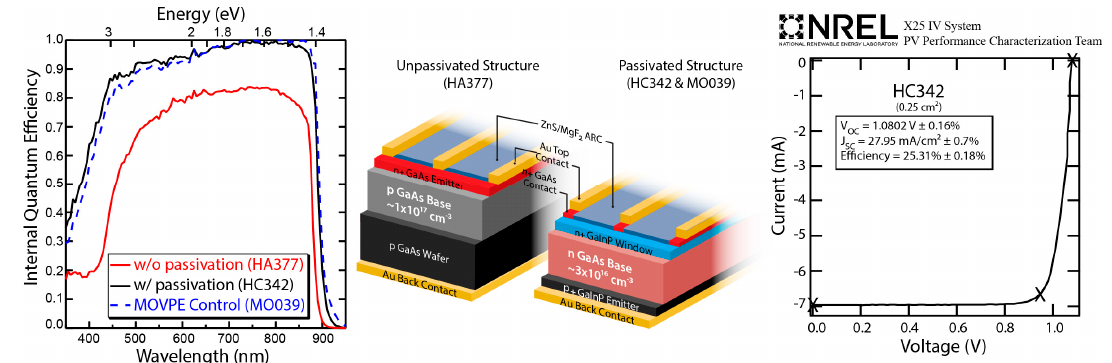
Figure 5. ( Left ) Internal quantum efficiency measurements of an unpassivated ( red ), and a fully passivated ( black ) single-junction GaAs solar cell, grown by D-HVPE at ~60 µ m/h. The dashed blue curve represents data from an MOVPE-grown device with nominally the same structure ( shown in the middle ), but grown at ~6 µ m/h. ( Right ) NREL-certified current-voltage data for the D-HVPE-grown GaAs solar cell with 25.3% conversion efficiency. It shows the current-voltage characteristics of a D-HVPE-grown single-junction GaAs solar cell, with front and rear passivation under simulated one-sun AM1.5G illumination. The device achieved a current density of ~28 mA/cm 2 , which matches the current density of the control MOVPE device grown with the same structure, and is only 6% lower than the record MOVPE device which utilized a more transparent AlInP window layer